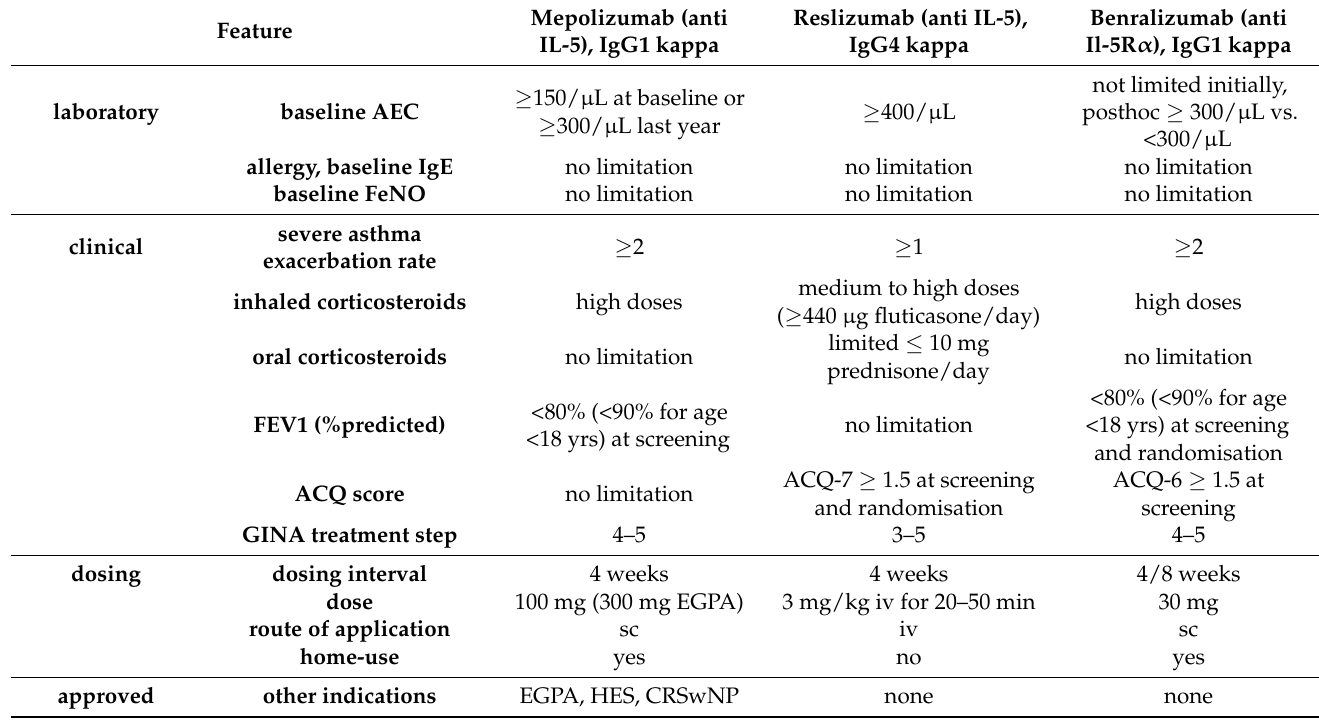
Table 5. Antieosinophil therapy for asthma patients.